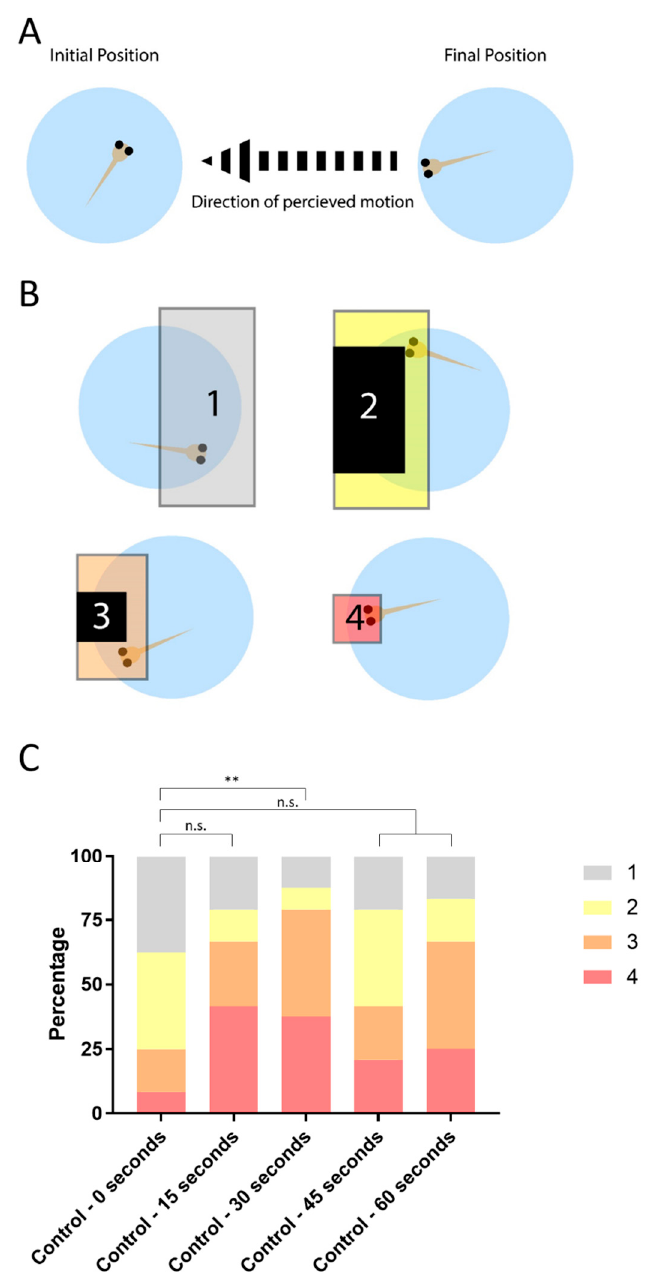
Figure 2. Scoring the embryo’s response to perceived motion with OMR. ( A ) Larvae start in a random orientation in the well, and respond to the OMR animation by aligning the direction of movement, to the left; ( B ) Each fish is scored based on its initial position, before the OMR, and its final position, after OMR exposure. The well is divided into four areas to indicate the level of alignment with 4 indicating high-alignment and 1 indicating a low-alignment; ( C ) 6 days post-fertilization control larvae ( n = 24) were exposed to the OMR stimulus for a total time of 60 s and the position of the larvae scored every 15 s. Larvae with 30 s exposure show a statistically significant difference from the 0 s baseline (exact binomial test p -value ** = 0.0072). n.s., not significant.